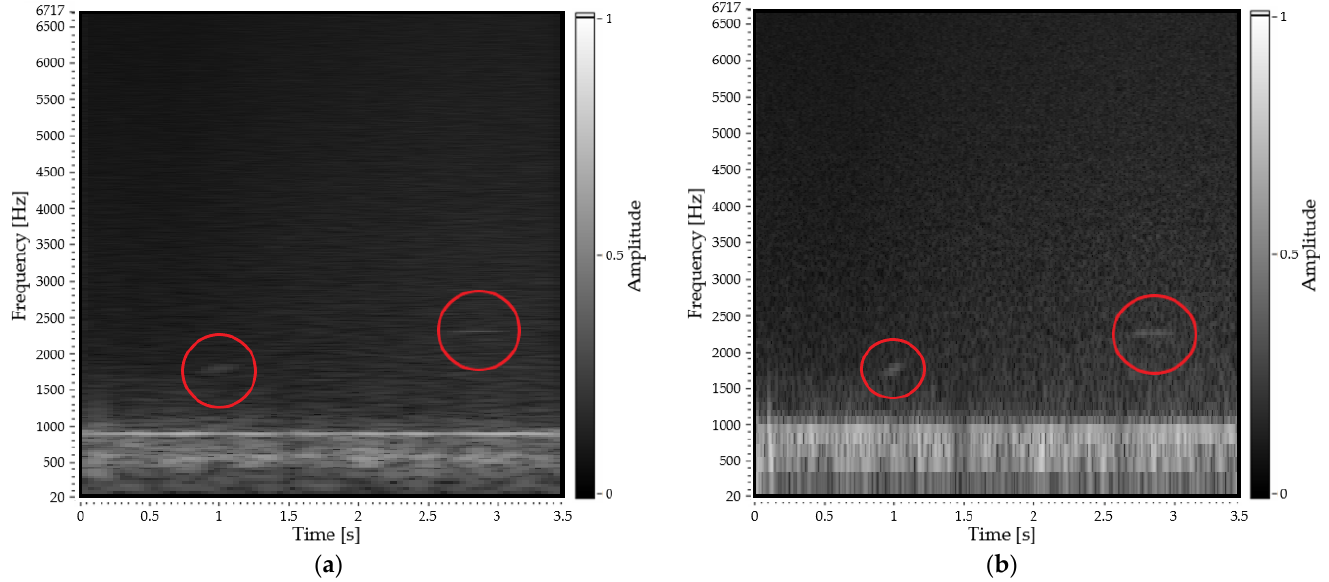
Table 3. Input parameters for creating both spectrogram types by Gabor transform.